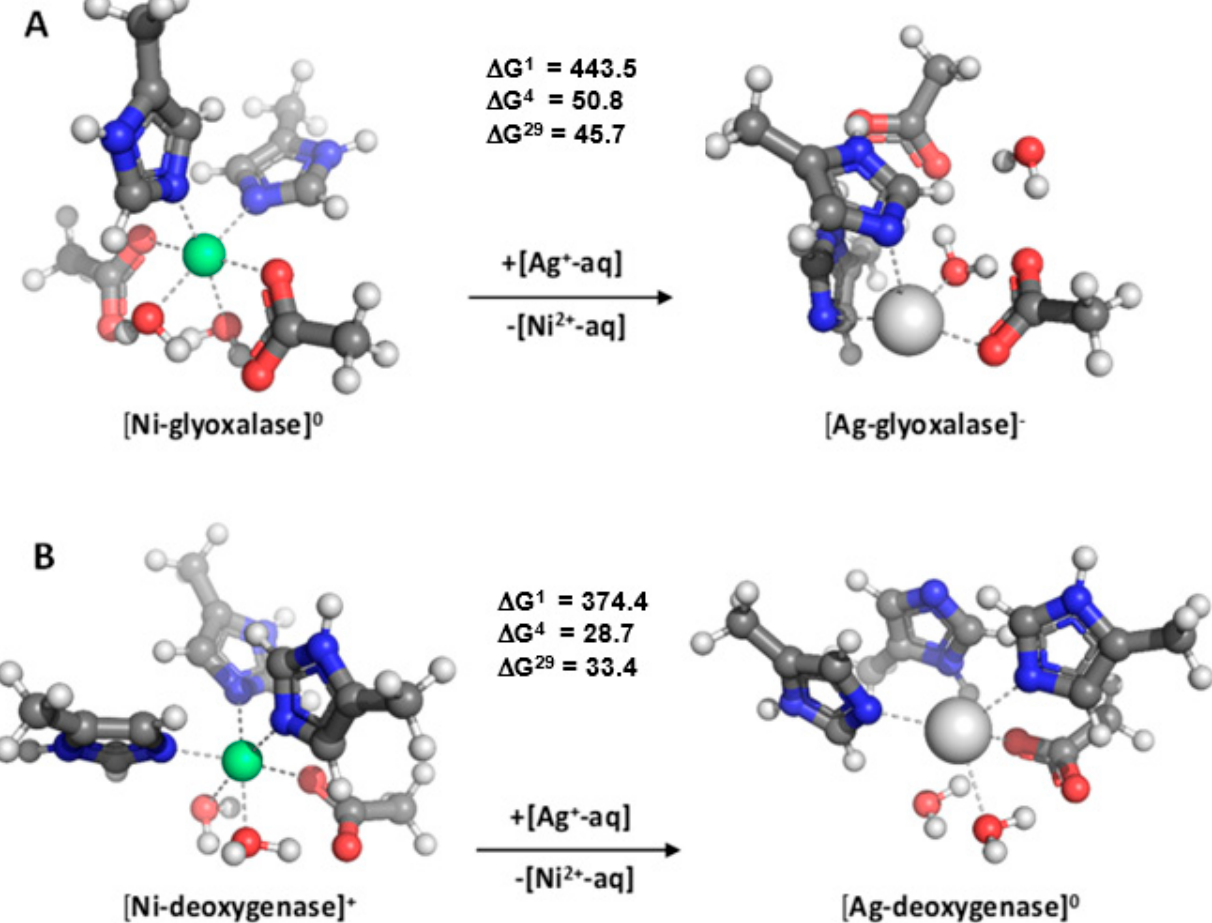
Figure 5. M06-2X/6-311++G** fully optimized glyoxalase ( A ) and acireductone dioxygenase ( B ) binding sites. The free energies ∆ G ε (in kcal mol − 1 ) for replacing Ni 2+ cation in the binding site characterized by dielectric constant ε with Ag + ion are shown in the middle. ∆ G 1 refers to cation exchange free energy in the gas phase, whereas ∆ G 4 and ∆ G 29 refer to cation exchange free energies in an environment characterized by an effective dielectric constant of 4 and 29, respectively. Positive ∆ Gs imply Ni 2+ selective binding sites. Adapted from Ref. [70]. Copyright 2022 Elsevier.